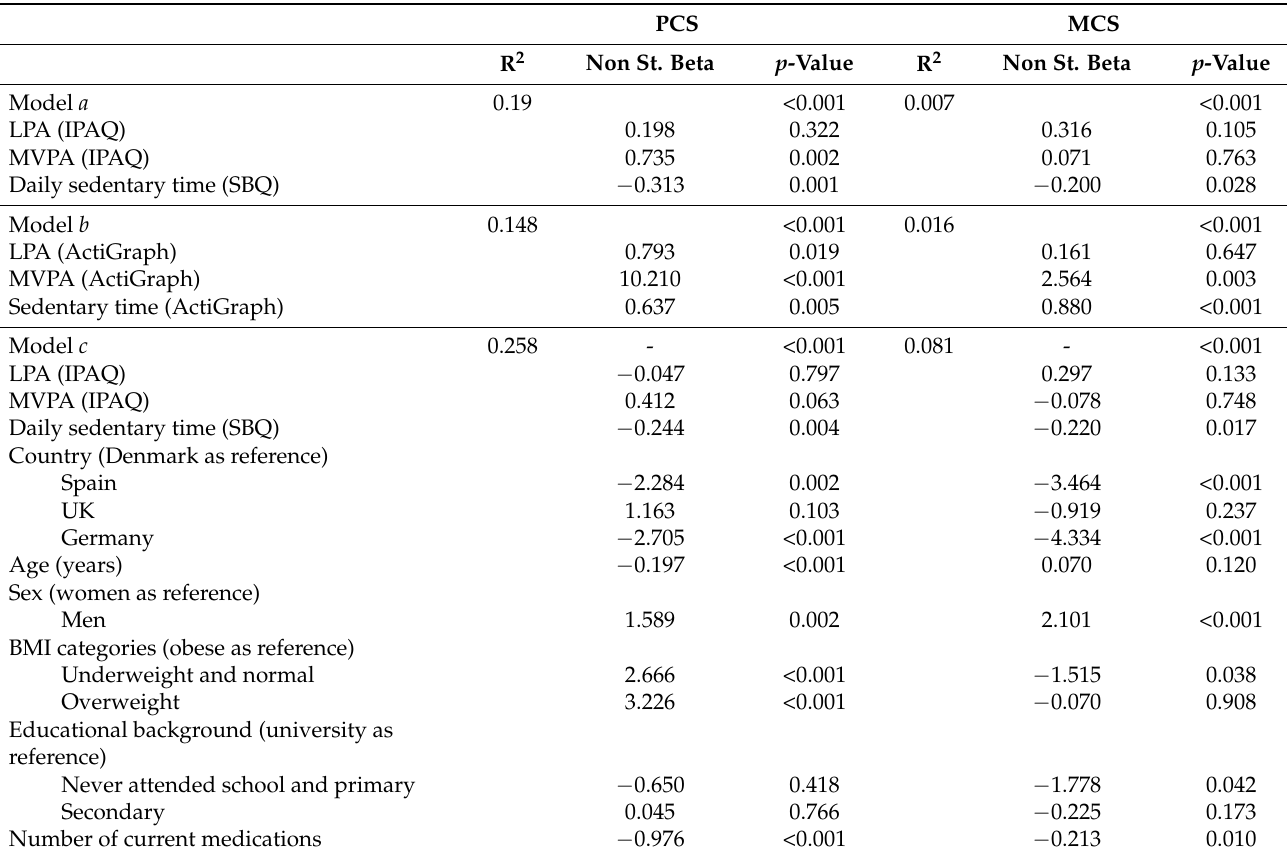
Table 3. Multivariate multiple regression models for PCS and MCS adjusted by self-reported and device-measured PA and SB